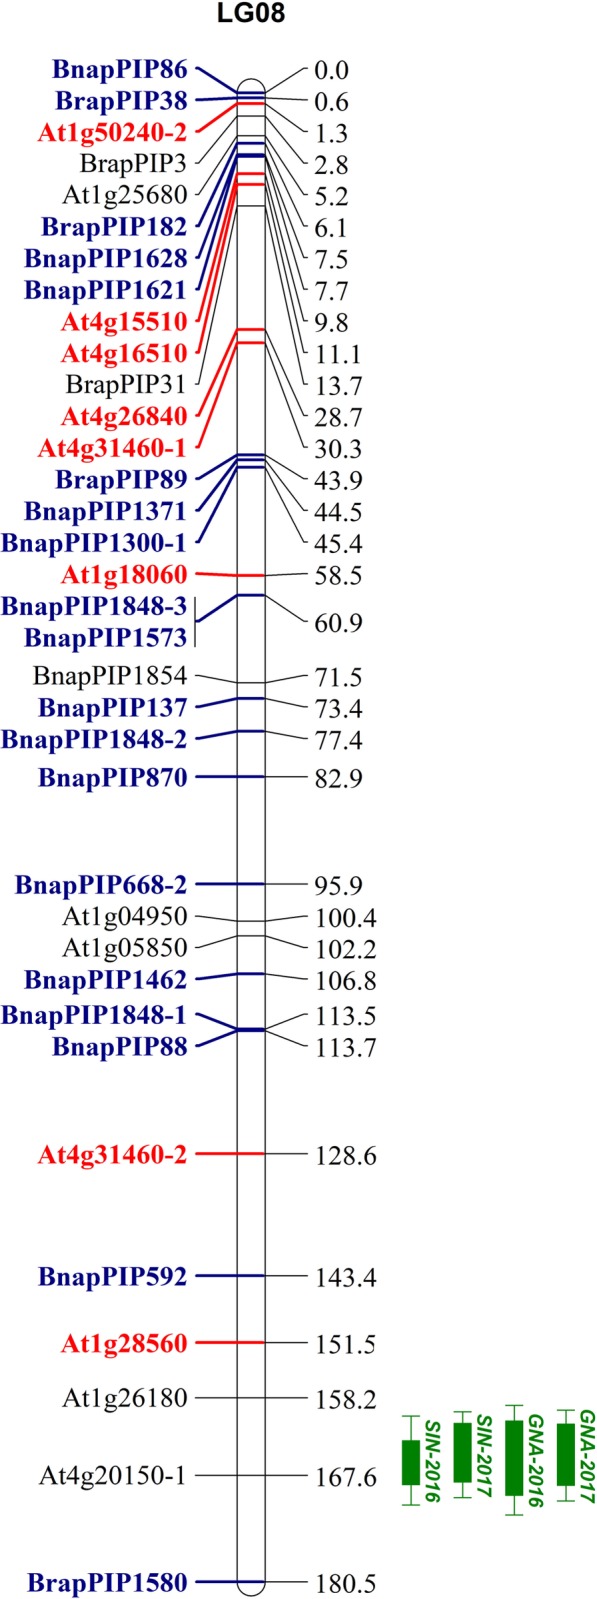
QTL mapping of 2-propenyl and 3-butenyl GSLs and synteny analysis between LG08 in the present study and A08 of B. juncea and B. rapa.The QTLs for 2-propenyl (SIN, Sinigrin) co-localized with the QTLs for 3-butenyl (GNA, Gluconapin) GSL content. 1-LOD and 2-LOD supporting intervals of each QTL were marked by thick and thin bars, respectively. Eight A. thaliana markers prefixed “At” (bold and red) on LG08 show a synteny with A08 of B. juncea in publish papers [32]. Eighteen ILP markers prefixed “Bnap and Brap” (bold and blue) on LG08 show a synteny between LG08 and A08 of B.rapa through balsting analysis with Brapa_1.0 of Brassica rapa cultivar Chiifu in NCBI (https://www.ncbi.nlm.nih.gov/).